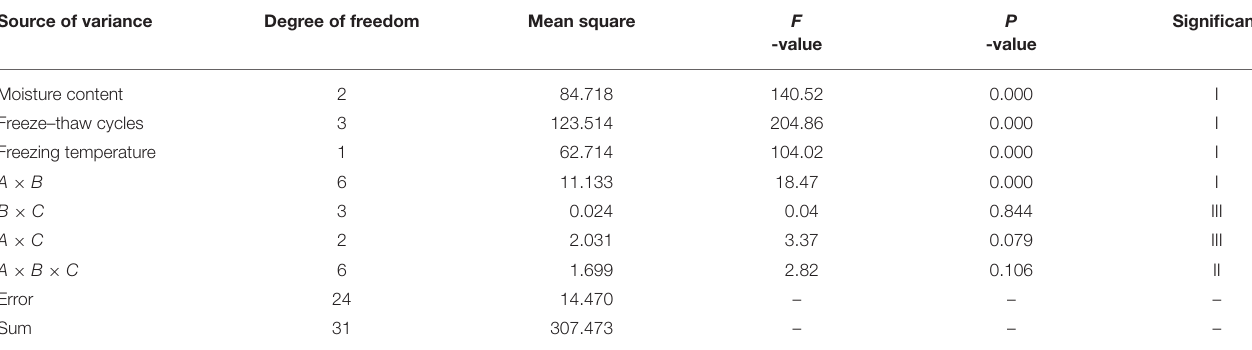
TABLE 3 | Analysis of unconfined compressive strength of sandstone–concrete samples. Source of